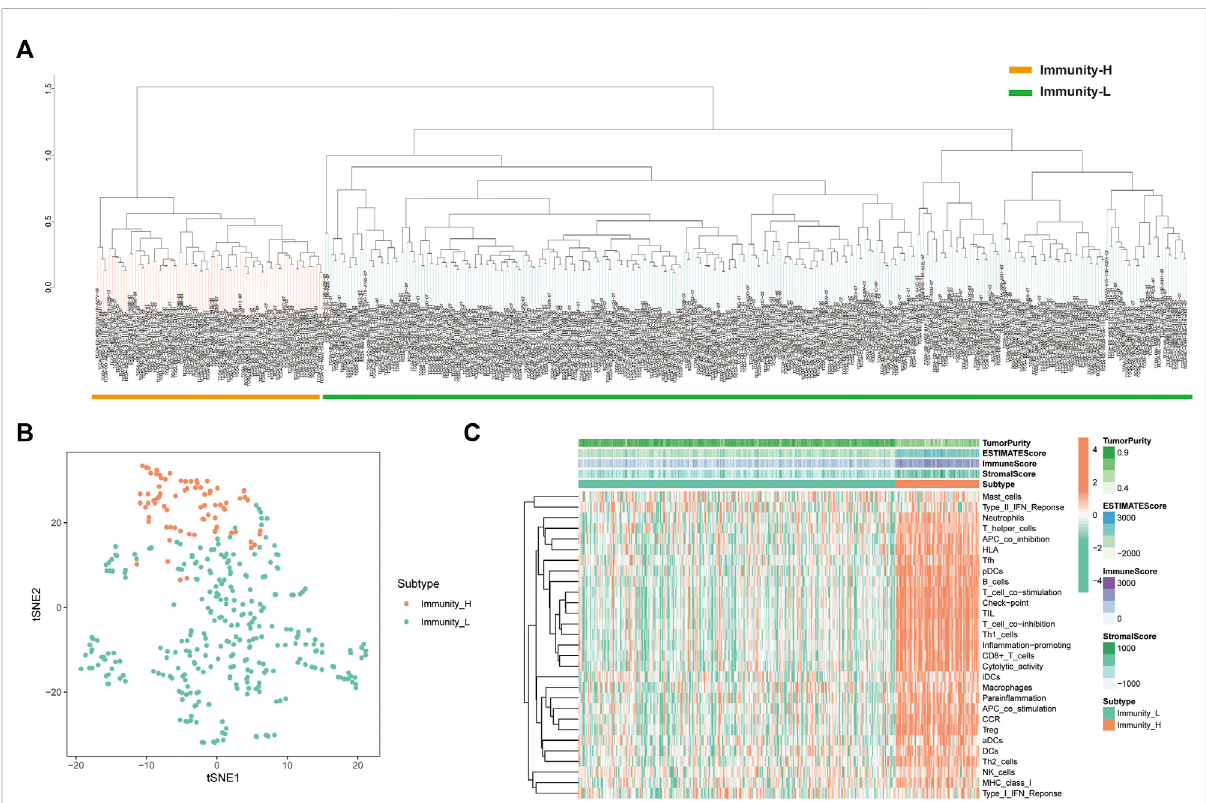
FIGURE 1 Singlesamplegeneset enrichmentanalysis-based immune clusteranalysis. (A) The hepatocellular carcinomasamples fromThe CancerGenome Atlas cohort were divided into a high immune cell in fi ltration cluster (orange) and a low immune cell in fi ltration cluster (green). (B) The principal component analysis plot ofthedistribution statusofthe high- and low-immuneclusters. (C) Enrichmentlevels ofdifferent types ofimmunecells inthe high- and low-immune clusters. Tumour purity, ESTIMATE score, immune score and stromal score are displayed for each sample in combination withclusteringinformation. (D) ViolinplotsofESTIMATEscore,immunescoreandstromalscoreindifferentimmuneclusters. (E) Theboxplotshowsthe differenceinimmunecellin fi ltrationbetweenthetwoclustersbasedontheCIBERSORTalgorithm. (F,G) Boxplotsshowthedifferencesintheexpression of immune checkpoint-related genes and HLA family genes in the two clusters, respectively. * p < 0.05, ** p < 0.01 and *** p <